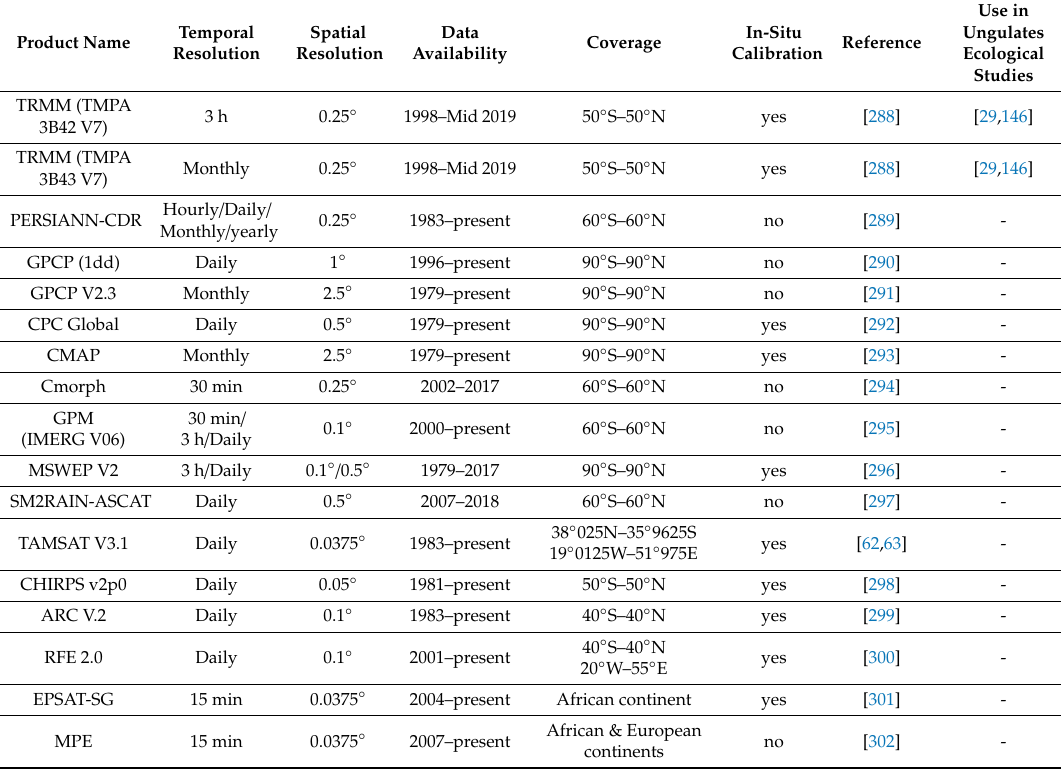
Table 8. Non-exhaustive list of available satellite-based precipitation